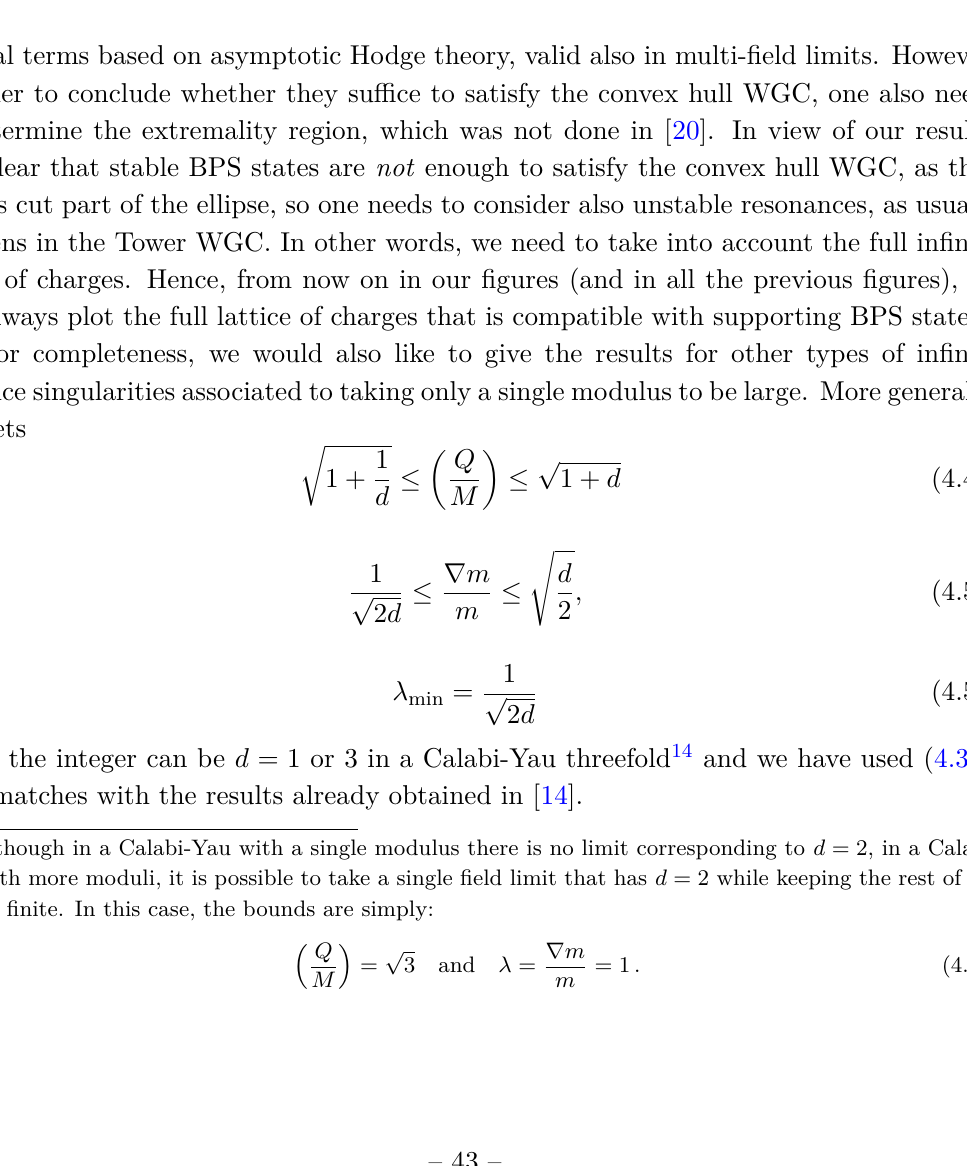
Figure 4. The charge-to-mass vectors for BPS states in a single field limit with d = 3 . The red ellipse indicates the extremality region, while the green points represent only those BPS states which are stable against crossing walls of marginal